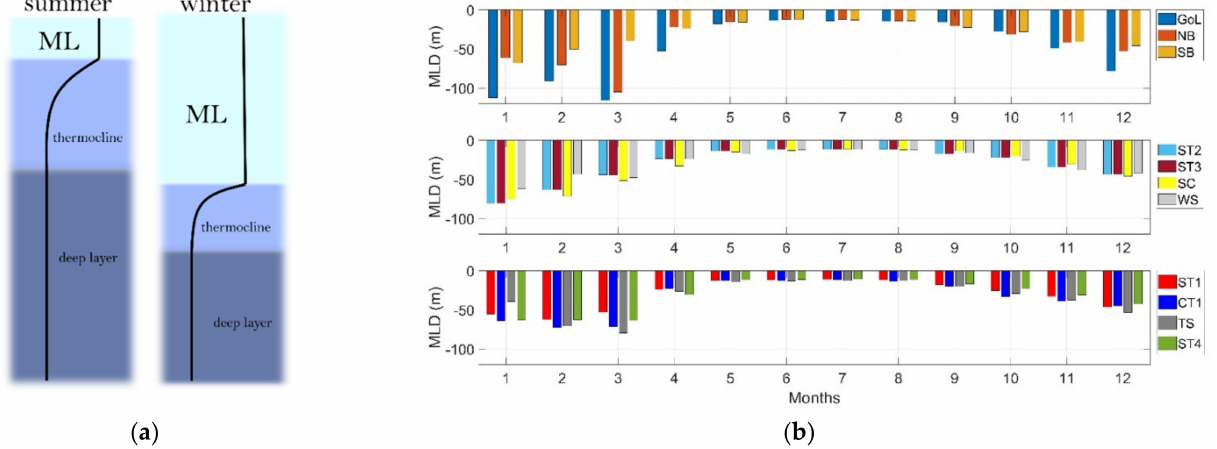
Figure 4. ( a ) Schematic vertical temperature profile highlighting the seasonal change of the three main oceanic layers; ( b ) the monthly climatological pattern of the MLD at the different sites, shown in the three areas that are discussed in the paper (northwestern Mediterranean, upper panel; Sardinia and Sicily Channel, central panel; and Tyrrhenian Sea, lower